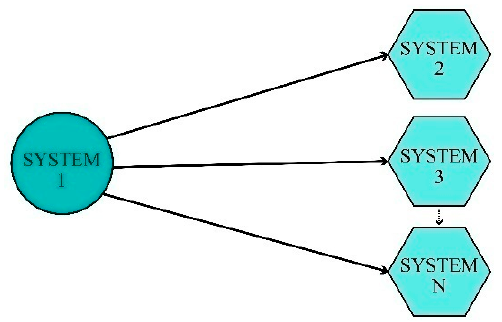
Figure 1. Transmission multi-mode synchronization.